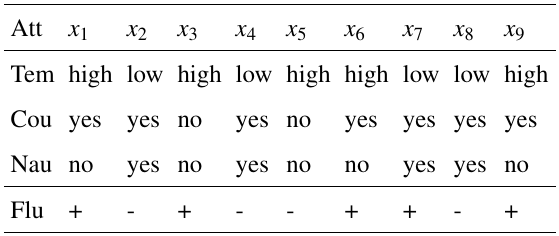
Table 1. An decision table for flu diagnose